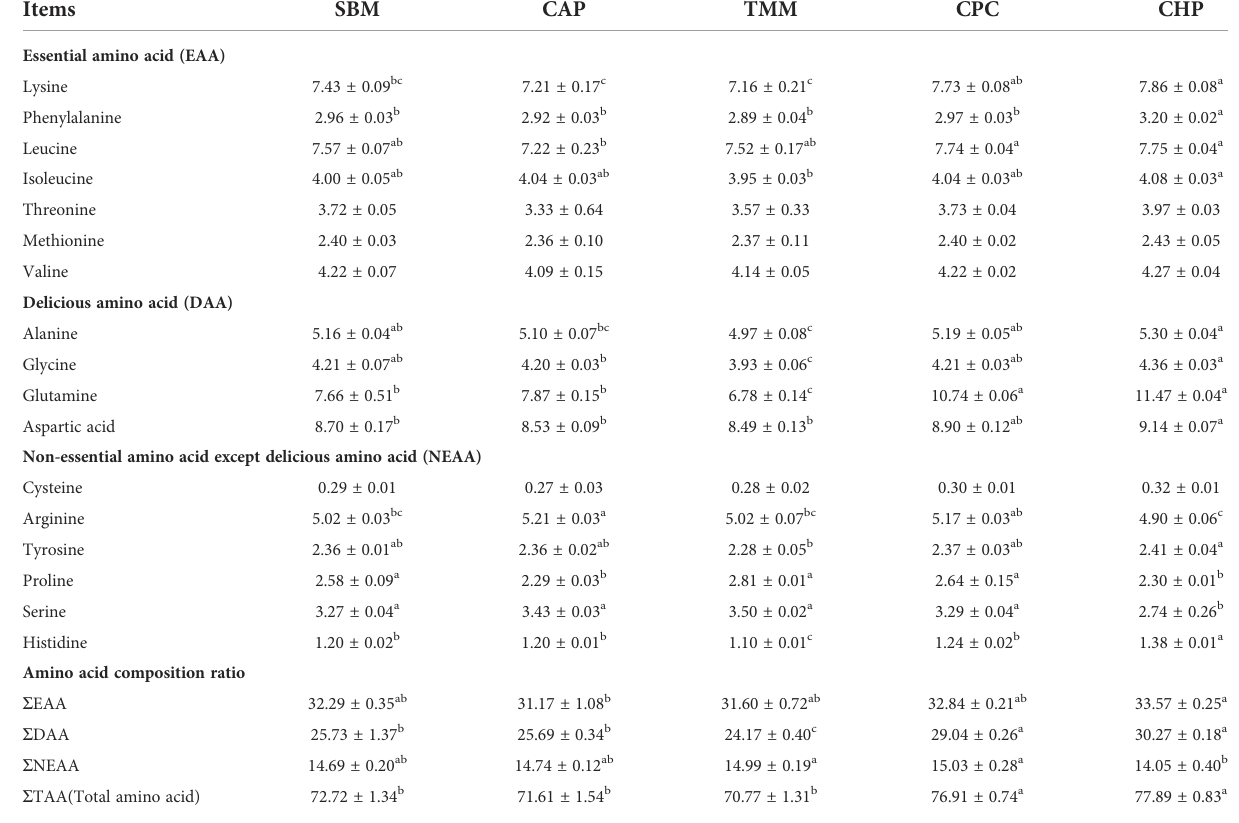
TABLE 7 Amino acid composition of grass carp muscle in small specimens (% dry-matter basis).